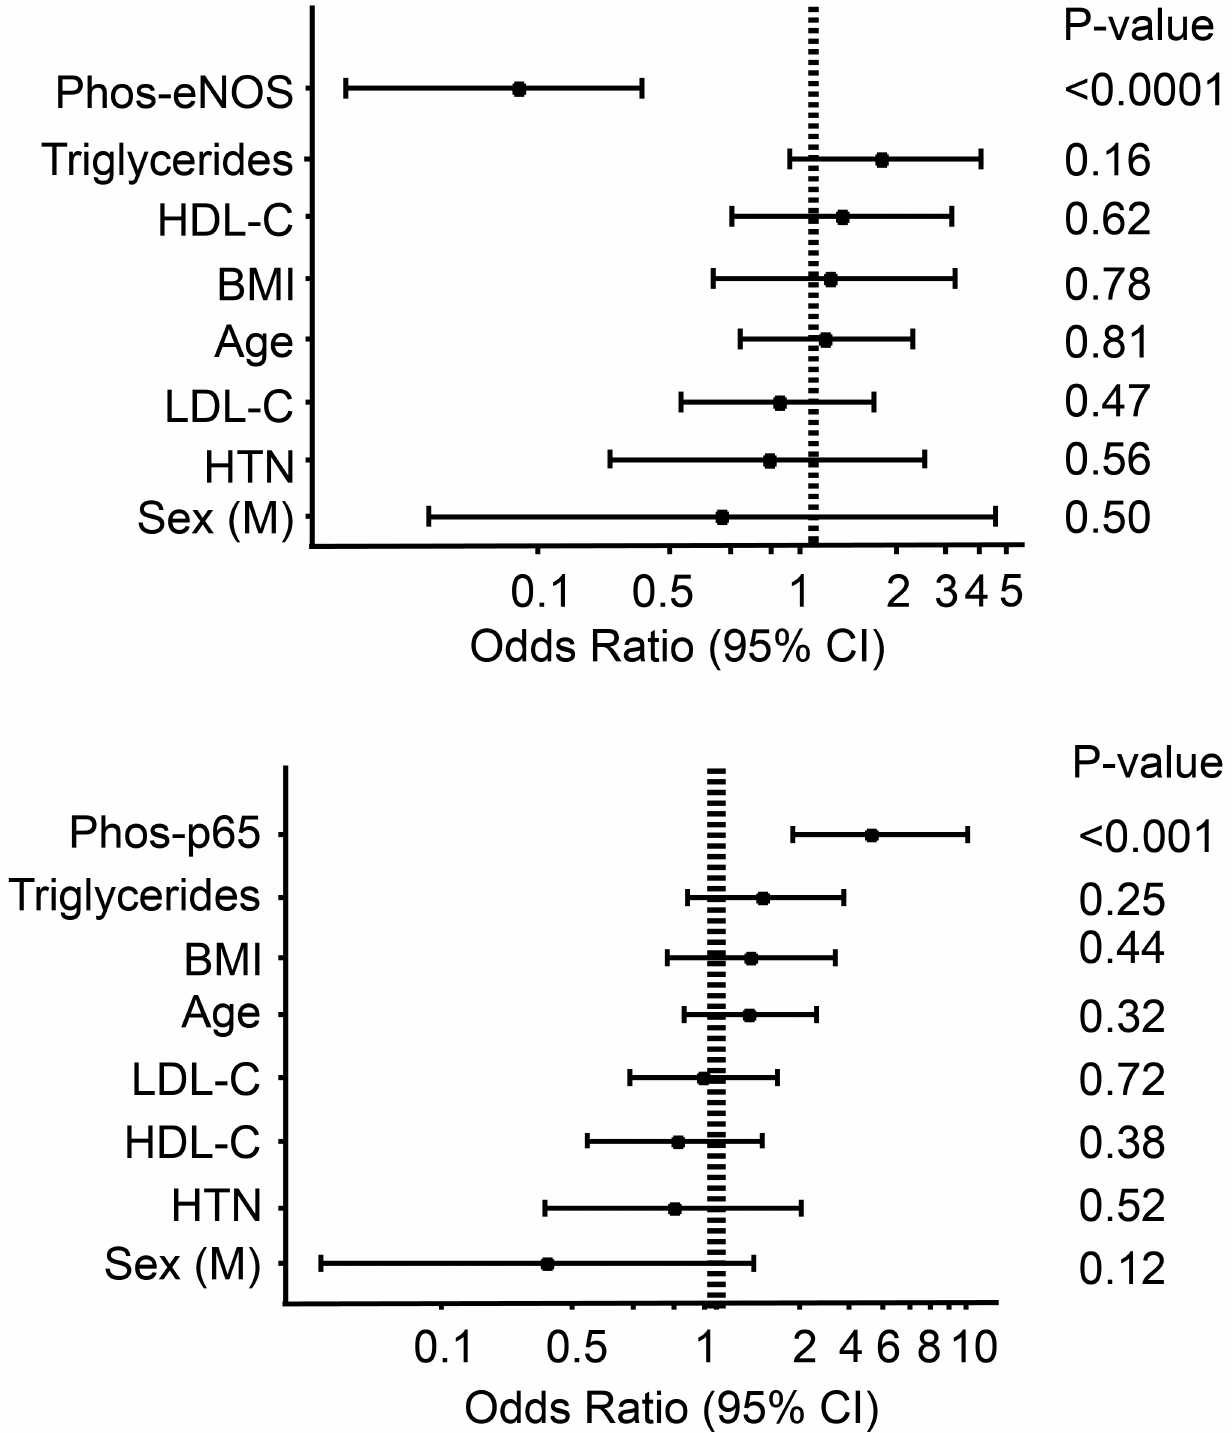
Fig 2. Odds ratios for type 2 diabetes according to HDL endothelial protective functions and selected dyslipidemia and common risk factors. Multivariate logistic regression models included the listed dyslipidemia and other cardiovascular risk factors and odds ratios for continuous variables are presented per 1-SD increase for (A) HDL ability to stimulate eNOS activation, and (B) for the suppression of NF κ B activation.